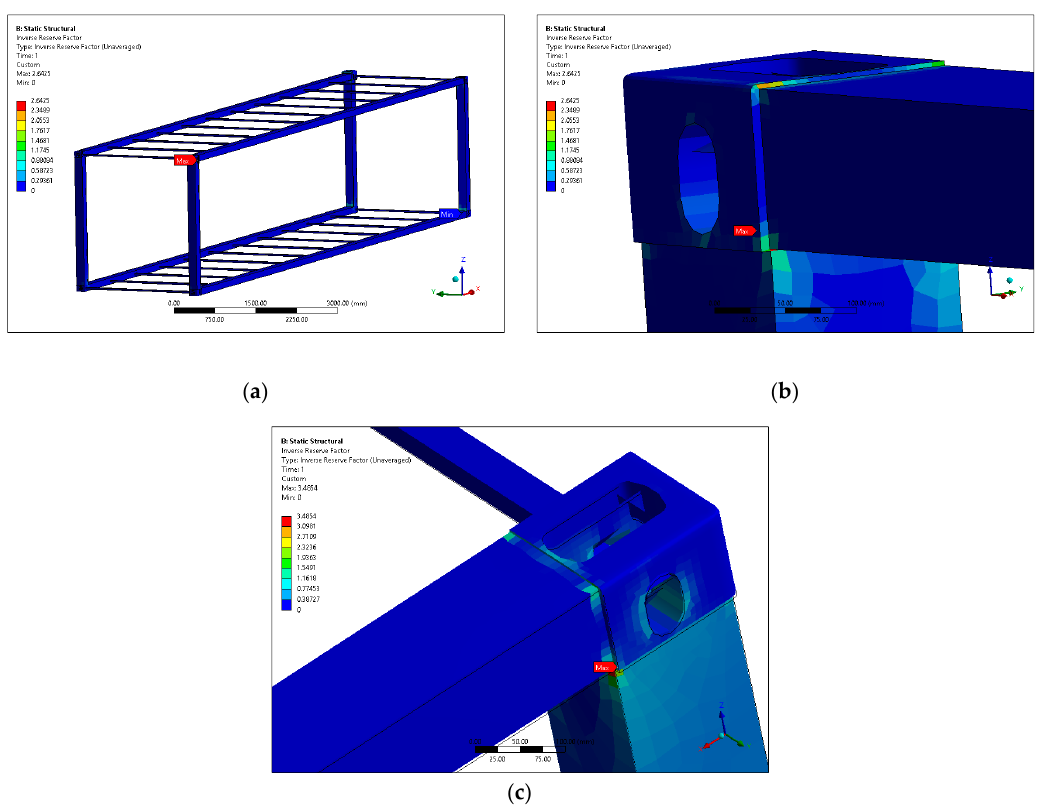
Figure 7 . Inverse reserve factor (IRF) analysis results. ( a ) The corners are under ~100 tons of load (1000 kN negative z direction), ( b ) IRF of the corner fitting: the corner is under ~100 tons of load (1000 kN negative z direction), and ( c ) IRF of the corner fitting: under ~100 tons pulling load (1000 kN positive z direction).